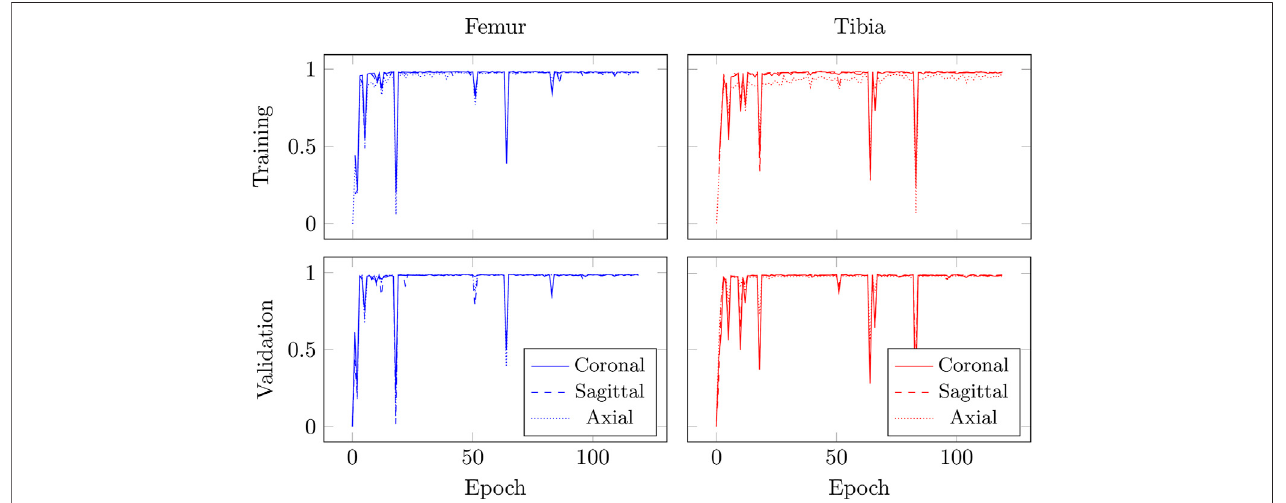
FIGURE5 | Evolutionof Jaccard index, measured on coronal,sagittal, and axial slices, for case #2(trainingset) and case #199(validation set) over 120epochs for CEL-UNet model during training.